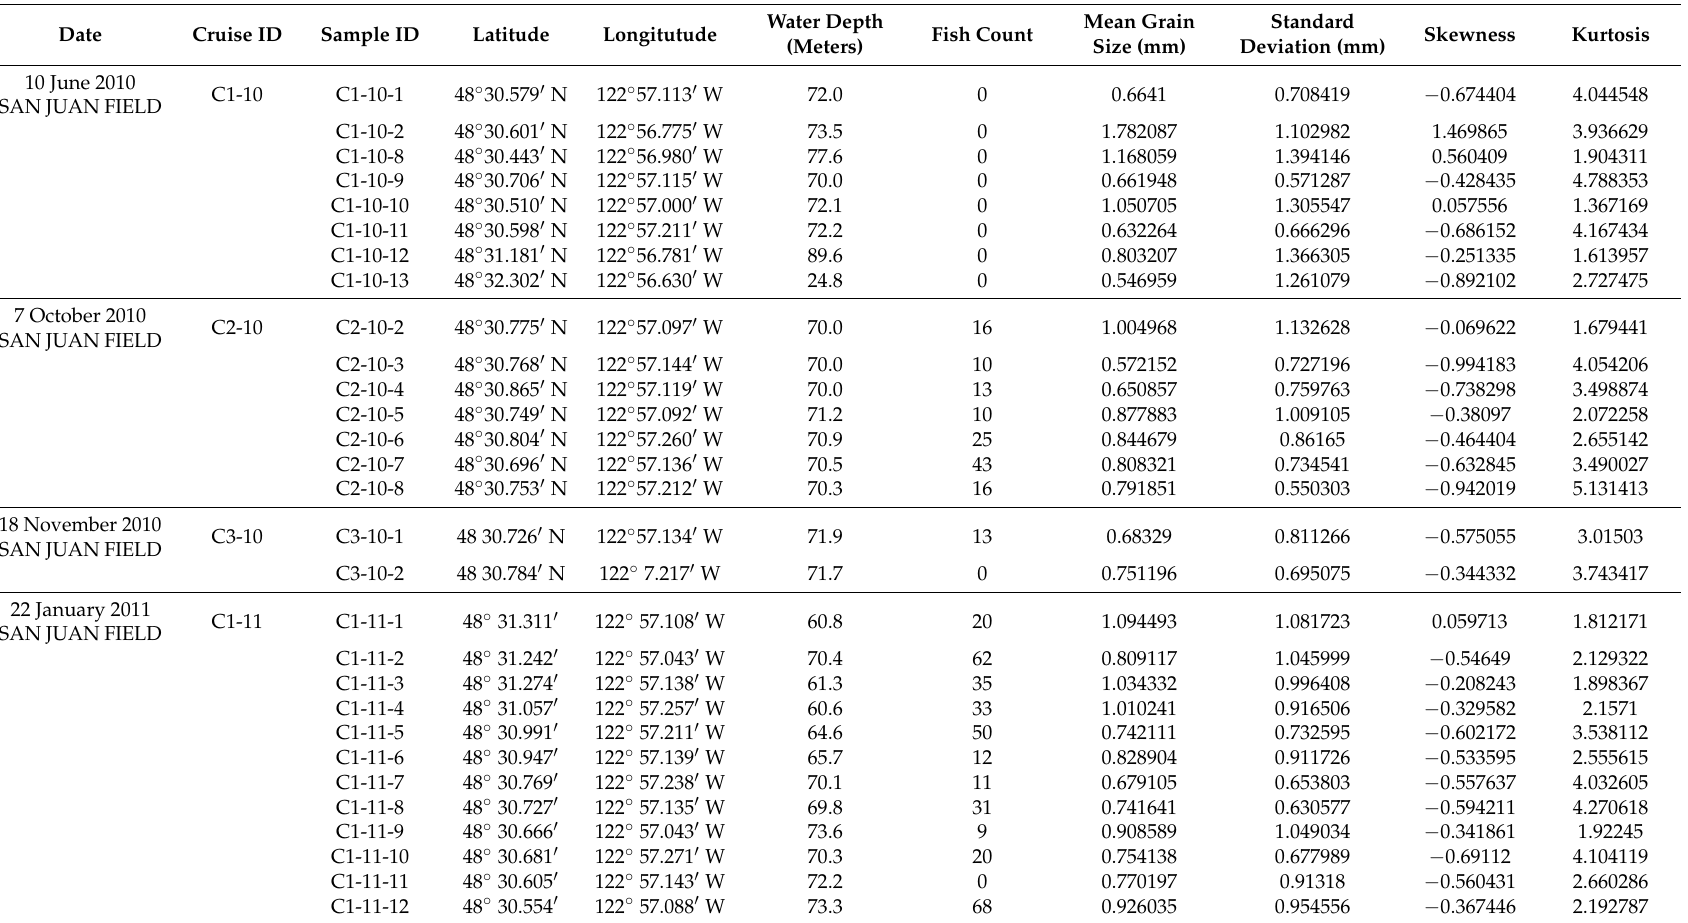
Table 1. Sediment Sample